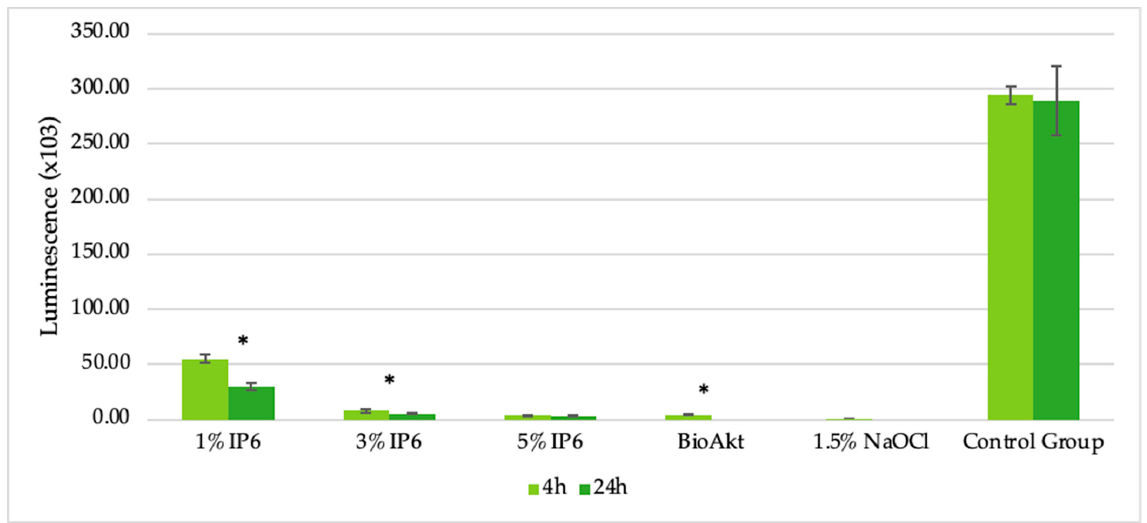
Figure 2. Cell-Titer Glo ® 2.0 Assay—* indicates statistically significant difference between 4 h and 24 h.